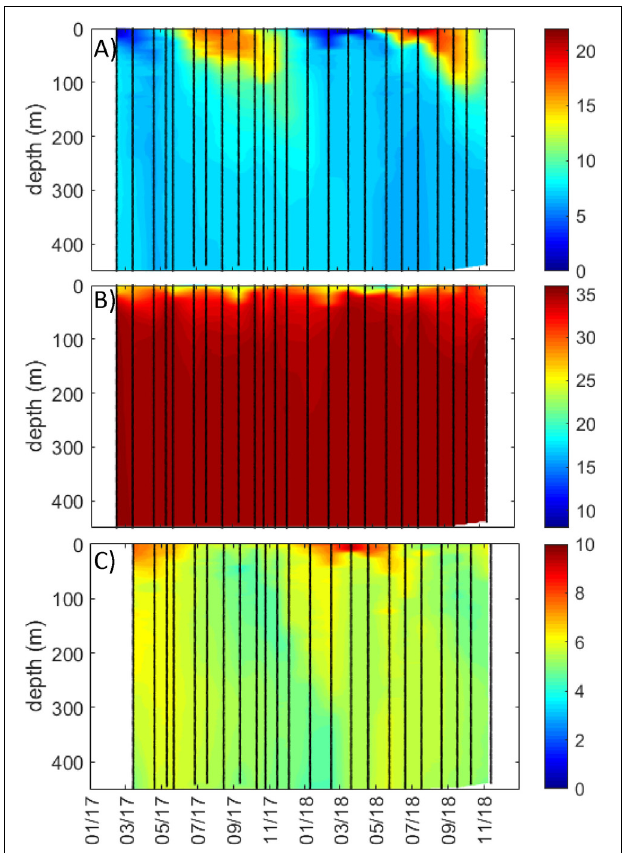
FIGURE 3 | Full water column profiles (from 0 m to near bottom) for coastal station Torbjørnskjaer in Outer Oslofjord/southern Norway study region for (A) temperature ( ◦ C), (B) salinity, and (C) oxygen (mL L − 1 ). Data are interpolated, with black symbols showing location of